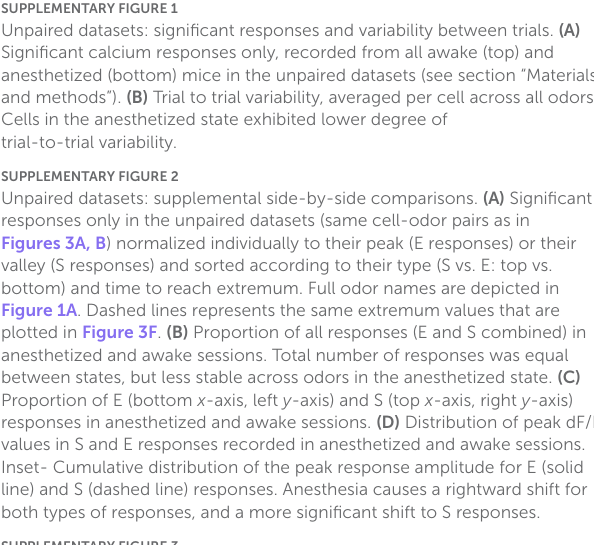
line) and S (dashed line) responses. Anesthesia causes a rightward shift for both types of responses, and a more significant shift to S responses. SUPPLEMENTARYFIGURE3 The paired dataset shows similar effects as the unpaired dataset. (A) Traces of significant S/E responses averaged across all odors in awake (blue)